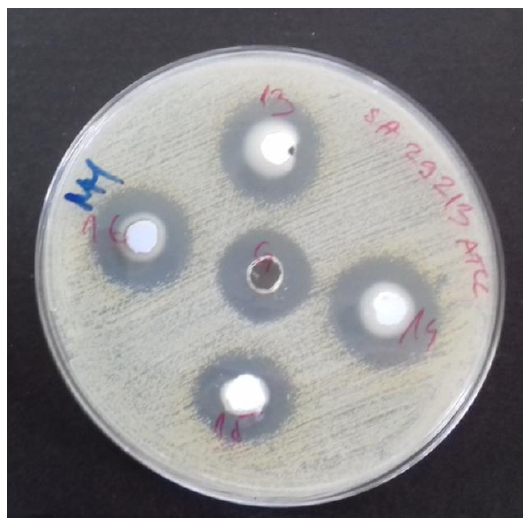
Figure 6. The plate after antimicrobial tests show potent antimicrobial activity against tested microorganisms